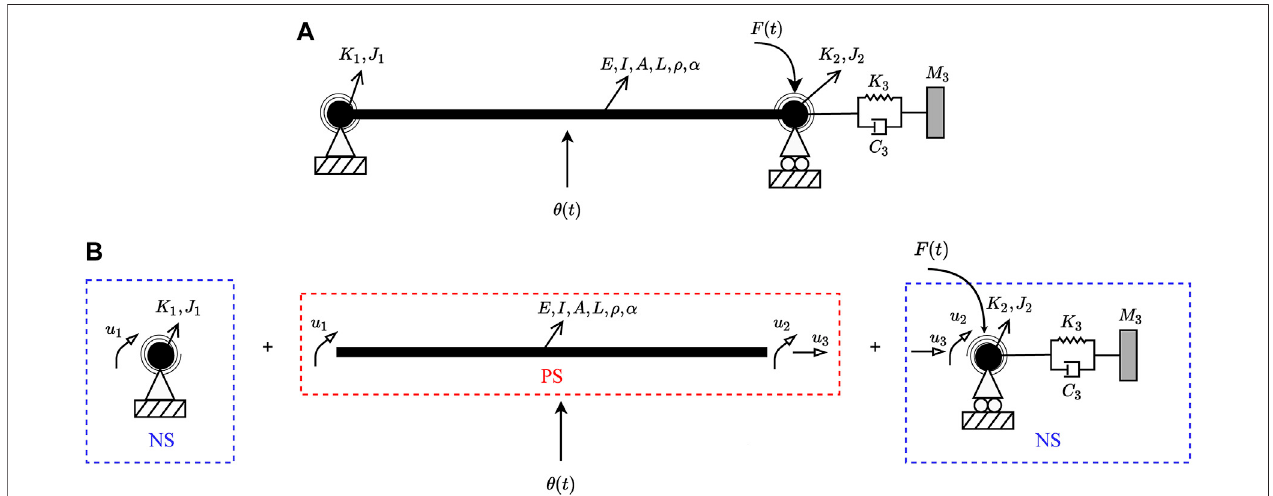
FIGURE 1 | Reference structural system: (A) prototype structure and (B) its hybrid model.